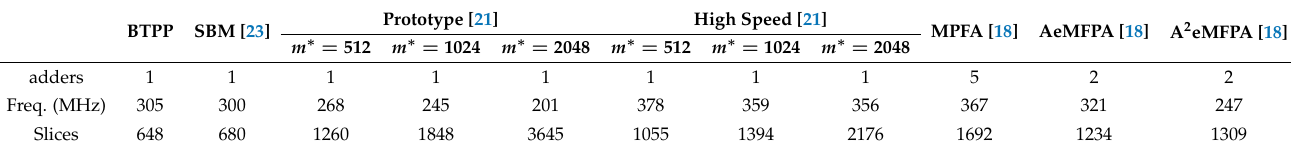
Table 1. Implementation results comparison between different designs on Xilinx XC5VLX110T.